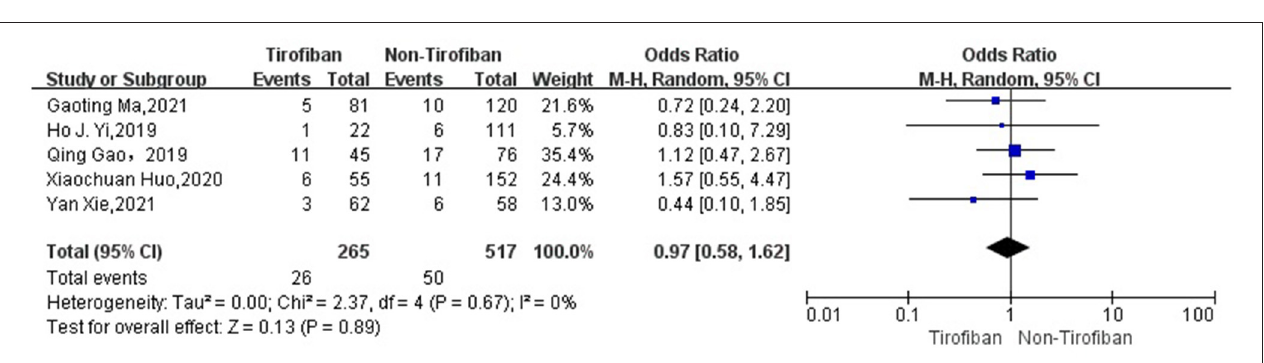
FIGURE 4 | Forest plot and meta-analysis of the incident of sICH. sICH, symptomatic intracerebral